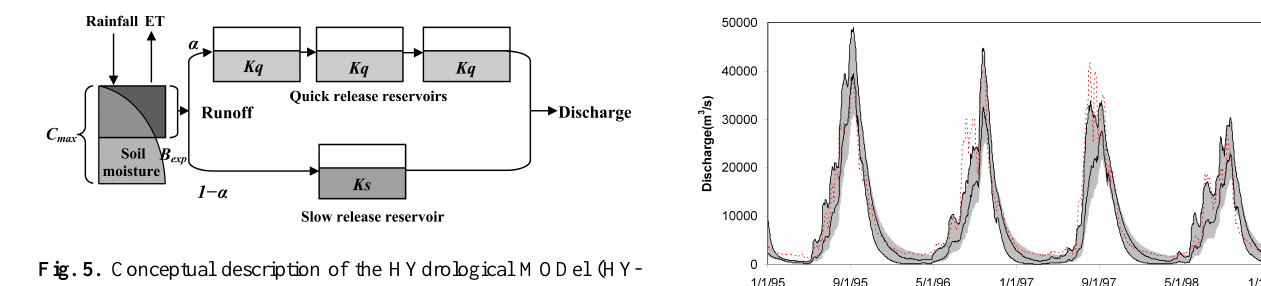
Fig. 5. Conceptual description of the HYdrological MODel (HY- MOD).